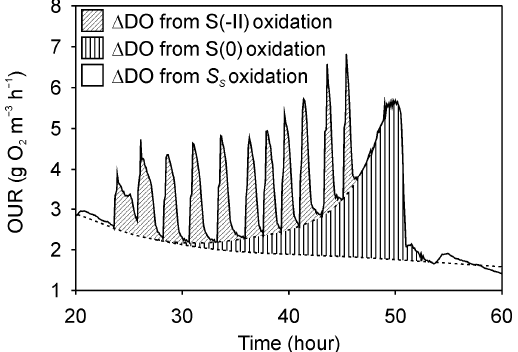
Figure 3. OUR response to 11 repeated sulfide additions. The oxygen consumed for oxidation of sulfide (cross-hatched area) and intermediates (hatched area) are indicated. sulfide (cross-hatched area) and intermediates (hatched area) are